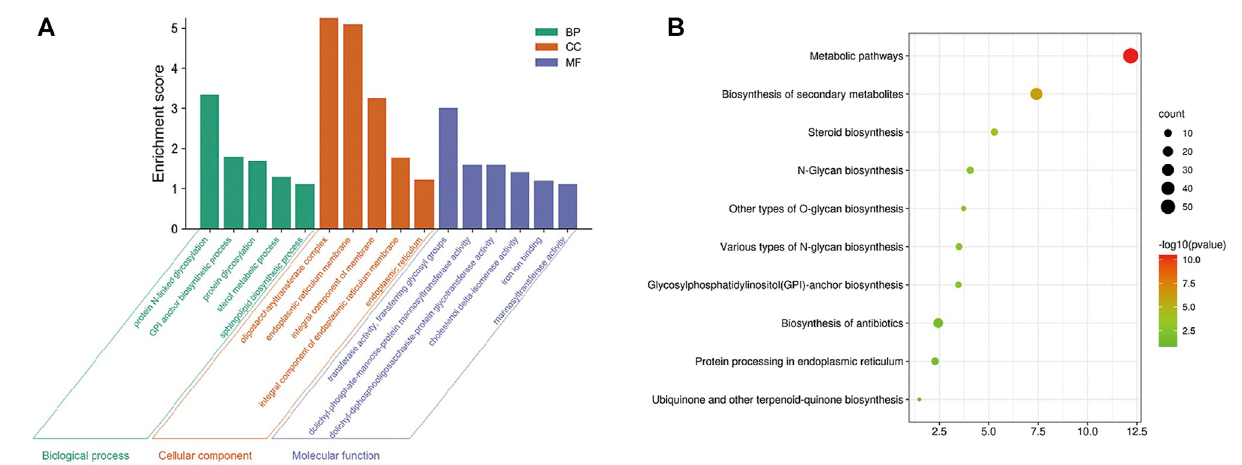
FIGURE 7 |(A) Go enrichment module diagram of M. oryzae . The fi rst three signi fi cantly enriched Go-terms ofthe biological process modules are protein N-linked glycosylation, GPI anchor biosynthesis process and protein glycosylation. The fi rst three signi fi cantly enriched GO-terms of the cell component modules are oligosaccharyltransferase complex, endoplasmic reticulum membrane, and integral component of the membrane. The fi rst three signi fi cantly enriched GO-terms of molecular function modules are transferase activity, transferring glycosyl groups, dolichyl-phosphate-mannose-protein mannosyltransferase activity, and dolichyl- diphosphooligosaccharide-protein glycotransferase activity. (B) KEGGenrichmentbubblediagram of M.oryzae .Thereare10signi fi cantenrichment pathways inKEGG enrichment pathways, which are mainly related to various glycan organisms, anchor organisms, steroid organisms, biosynthesis of secondary metabolites, protein processing and metabolic